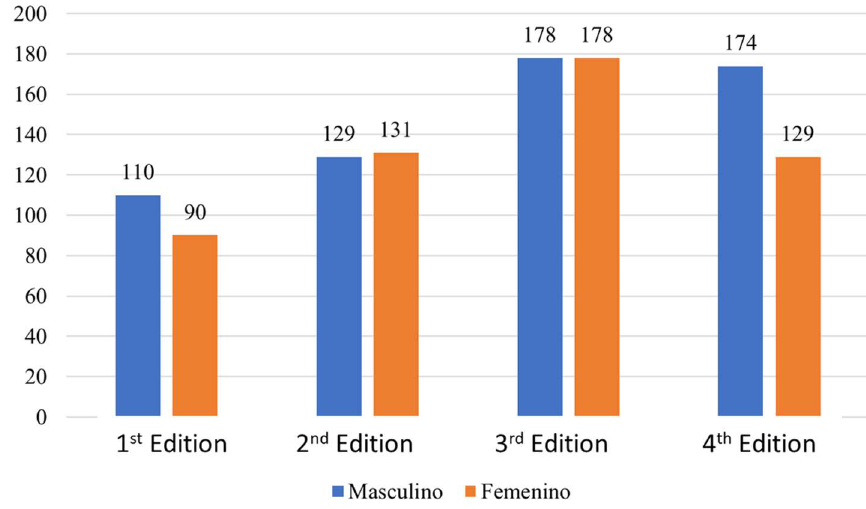
Figure 6. Distribution per sexes of the different participants, Source: Own elaboration.